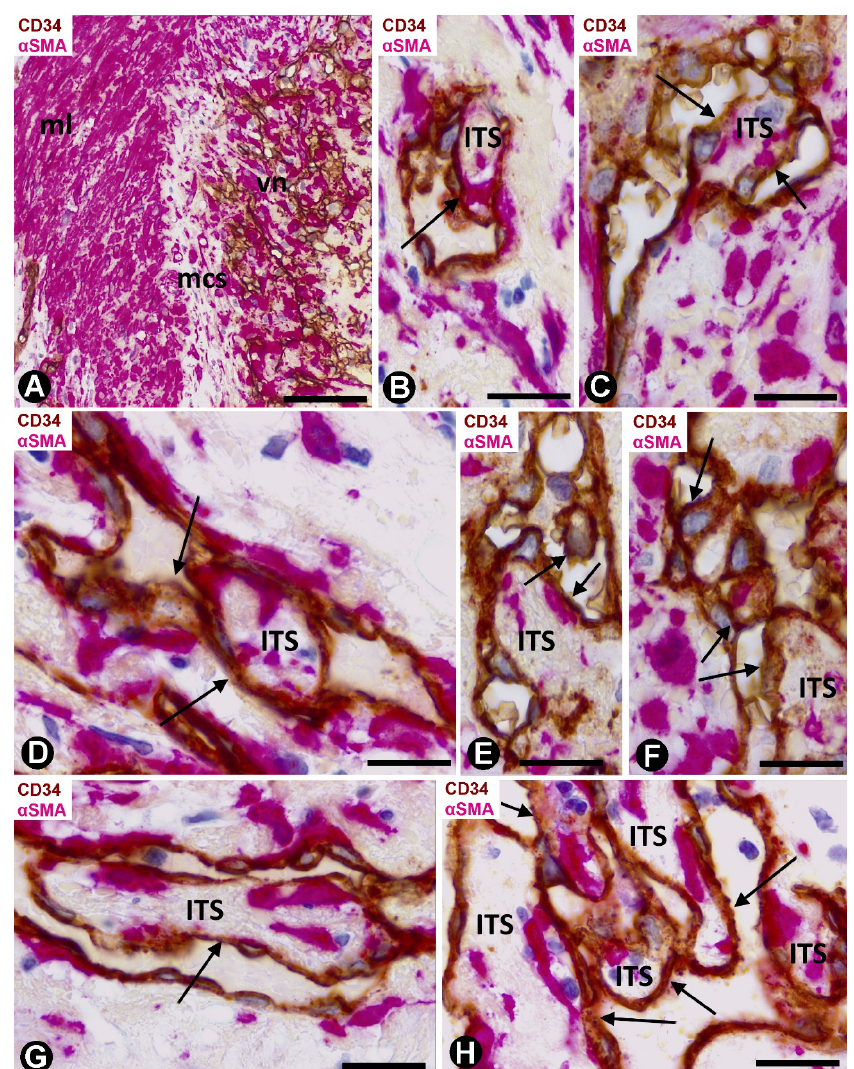
Figure 3. Arteries in gallbladders with acute cholecystitis and urgent cholecystectomy. Sections double-immunostained with anti-CD34 (brown) and anti α SMA (red). ( A ) Region with early intimal thickening formed by myointimal cells (mcs) and the underlying vessel network (vn) (ml: media layer). ( B – H ) Several images of vessel loops, ITSs and endothelial bridges, forming pillars (arrows). Note that ITSs containing cells expressing α SMA are surrounded by the inner layer of the loops and are partially or totally located in the vessel lumens. Occasionally, ITSs form complex structures ( H ). Bar: ( A ): 80 μ m; ( B – H ): 10 μ m.